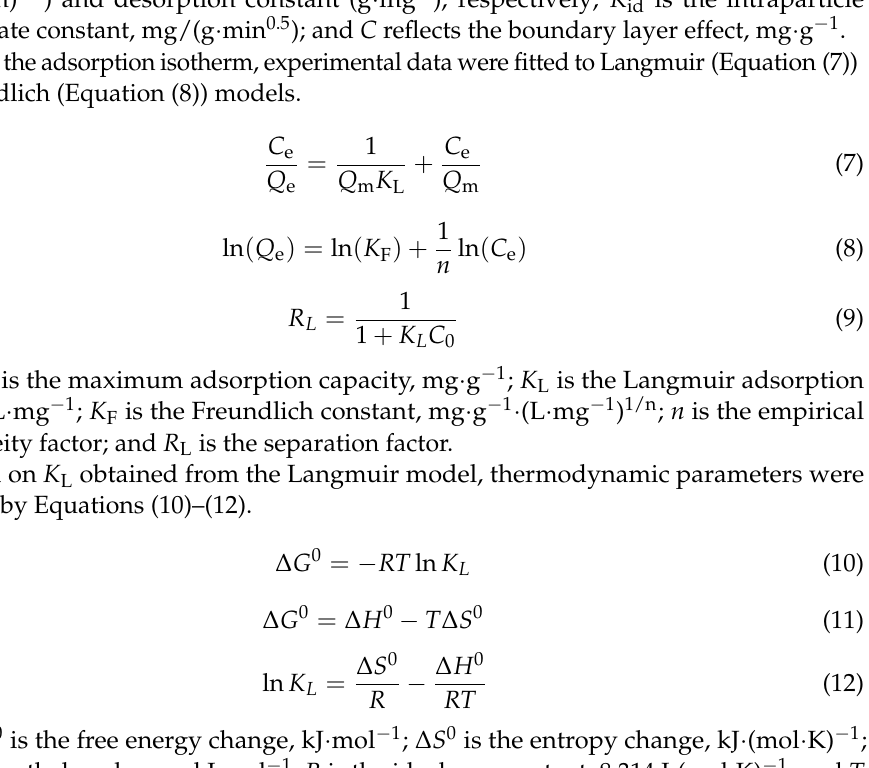
Table 1. The specific surface area of MSBC-2 was 63.68 m 2 · g − 1 , which was higher than